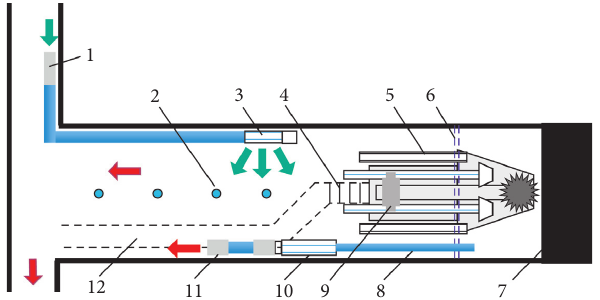
Figure 1: Roadway layout after installing ACDRD. (1) Forcing fan; (2) dust measuring spots; (3) dust removal device; (4) reproduced bridge; (5) S200MJ roadheader; (6) air curtain; (7) heading face; (8) air duct; (9) ACDRD; (10) dust collector; (11) exhaust fan; (12) belt conveyor.